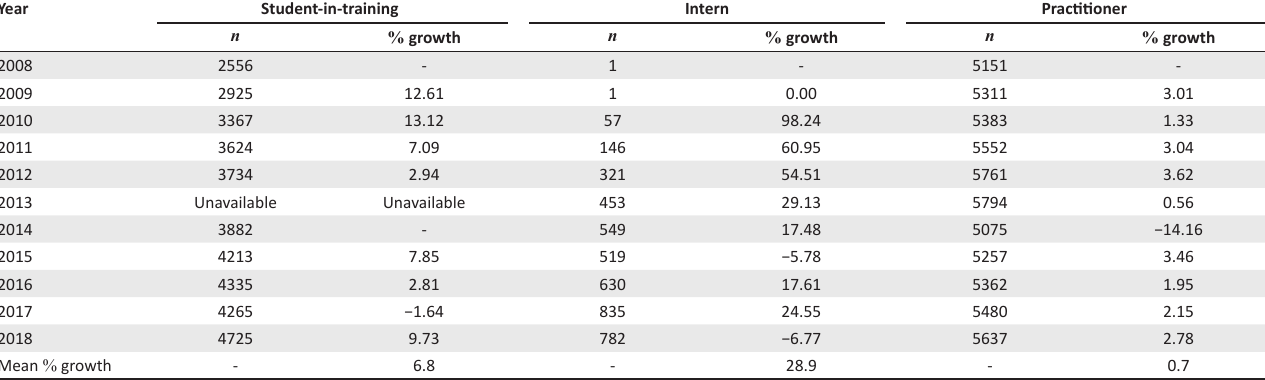
TABLE 1: Growth rate patterns of student, intern and practitioner registries of the South African medical technology profession (2008–2018). Year Student-in-training